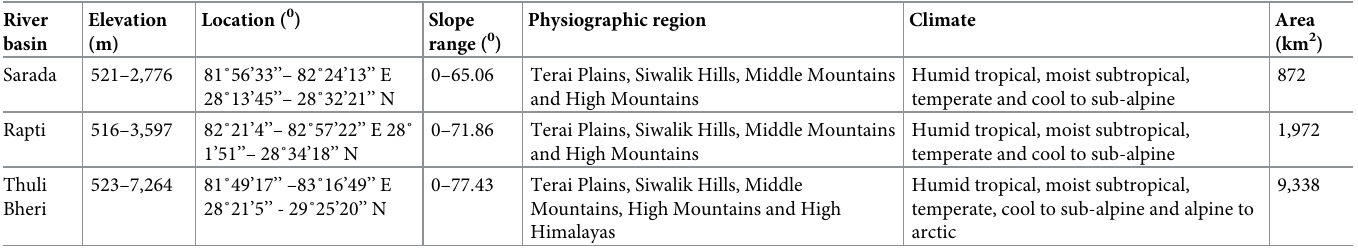
Table 1. Location and coverage of the study